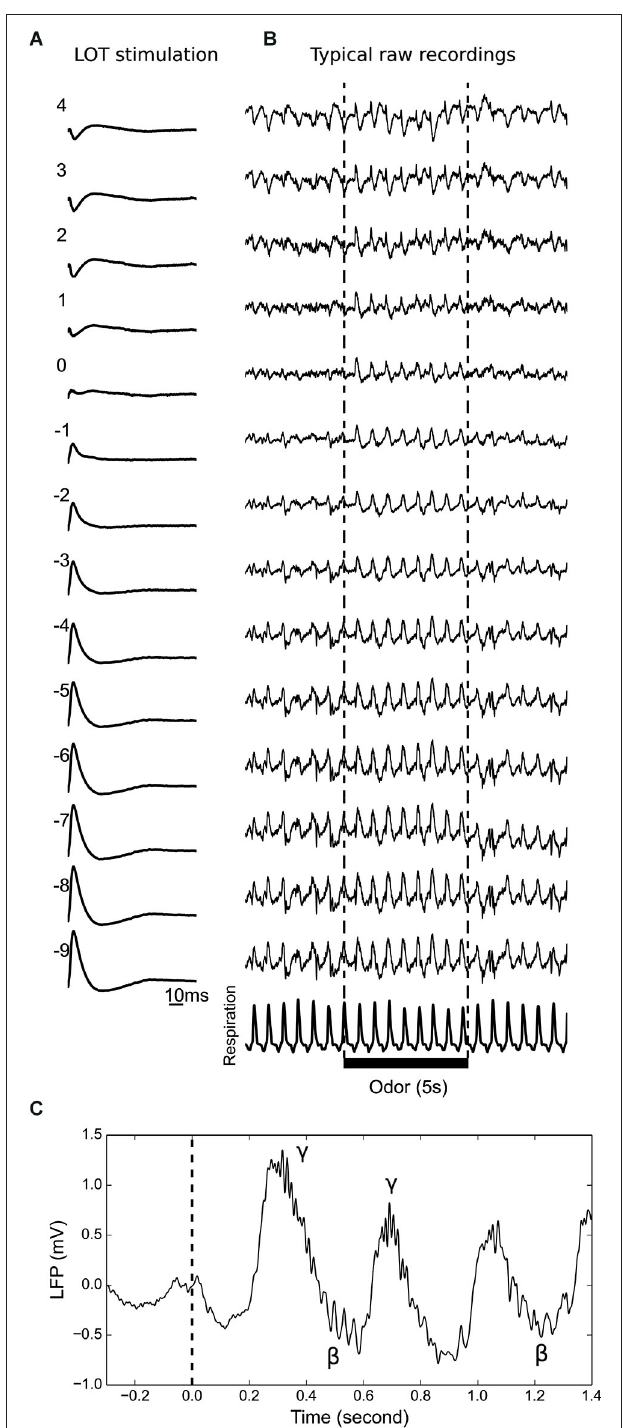
FIGURE 1 | Determination of the mitral cell layer and multielectrode recording examples. (A) Typical recordings at 14 locations along the silicon probe during electrical LOT stimulation. The electrode closest to the signal inversion is numbered 0, which is consequently designated as the closest to the MCL. The EPL and GL are above, and the GRL is below. (B) Typical 15 s recording displayed together with the respiratory signal. Odor presentation is indicated by the black bar. During the SPONT period, there ( Continued